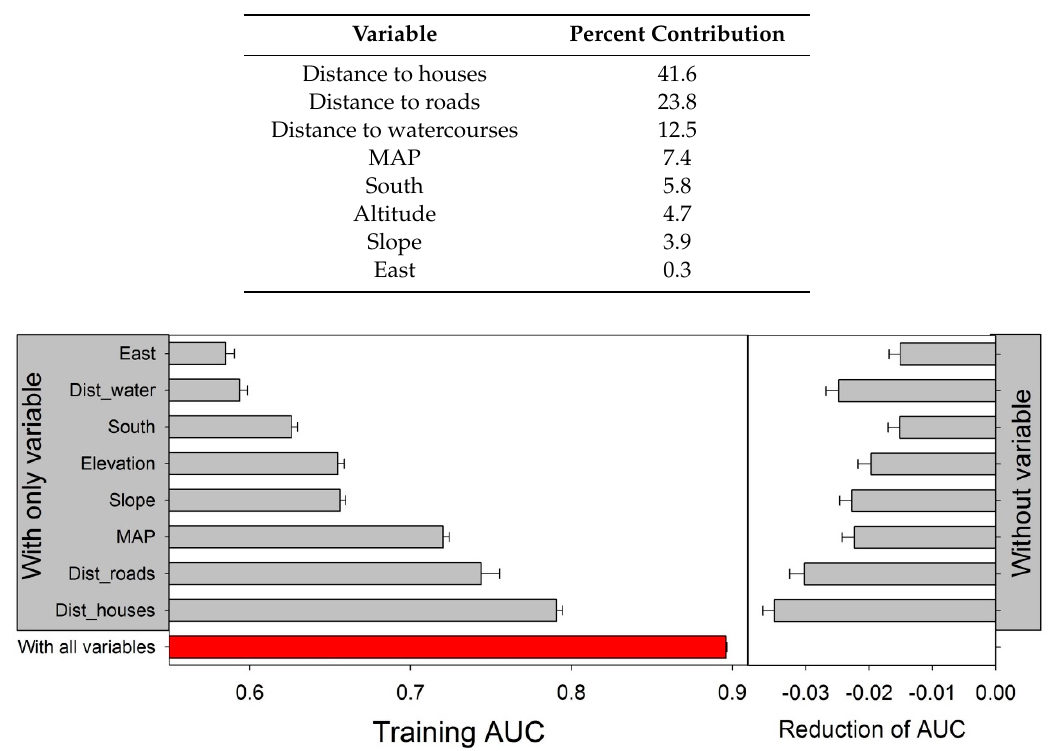
Table 1. Relative contribution of the anthropic and environmental variables to the MaxEnt model. MAP: mean annual precipitation; South: relative south aspect; East: relative east aspect.